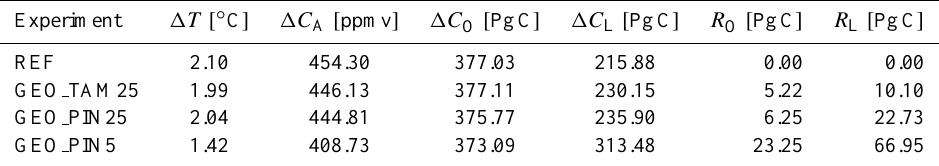
Table 2. Simulated change in global mean temperature ( 1T ), atmospheric CO 2 concentration ( 1C A ), oceanic ( 1C O ) and terrestrial ( 1C L ) carbon content, and residual carbon uptake ( R O and R L ) computed over the 2020–2099 period.